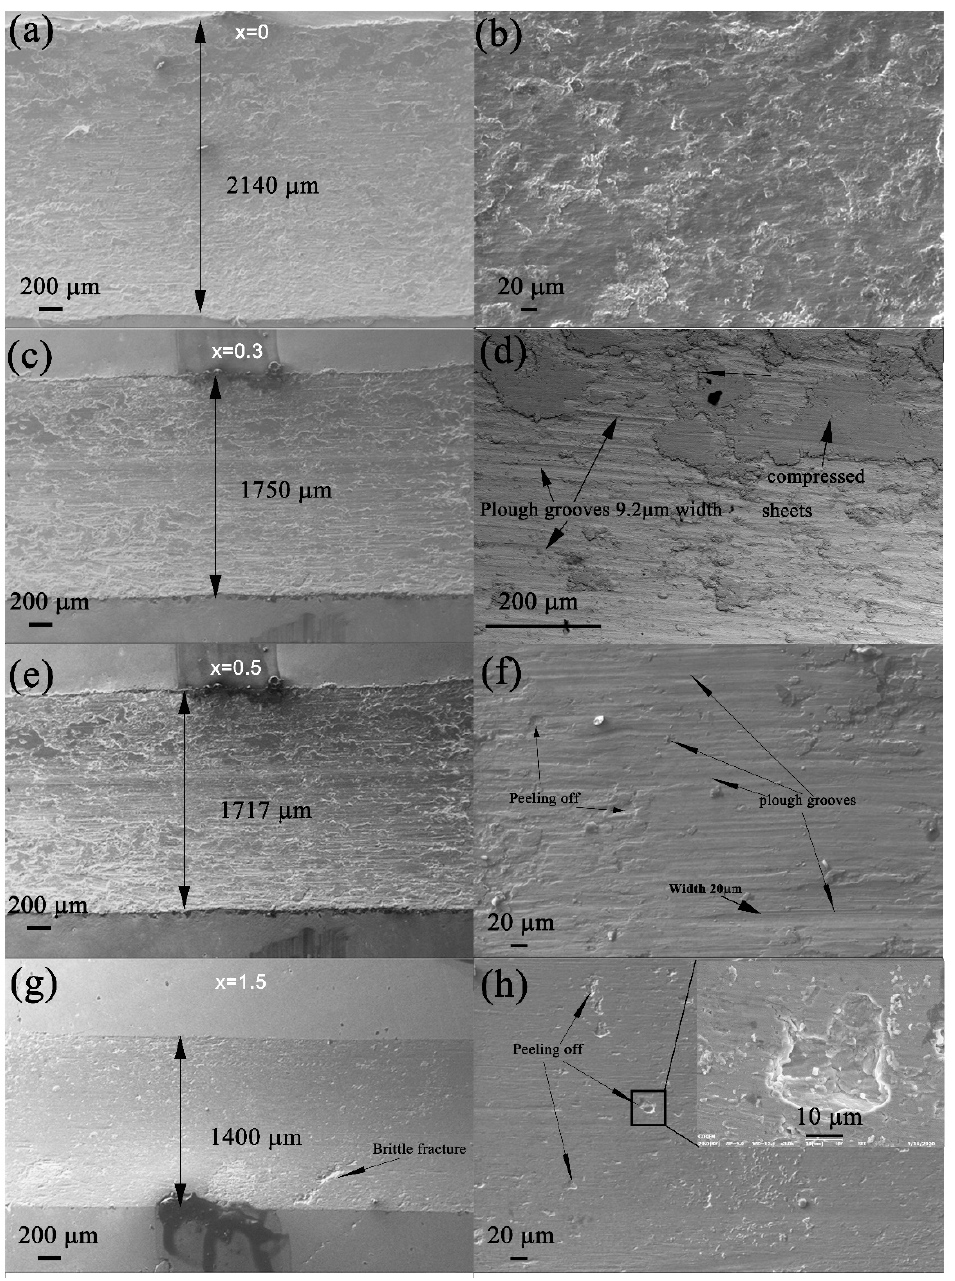
Figure 11. Volume loss, specific wear rates, and the average surface roughness (Sa) of wear scars for Mo x ( x = 0, 0.3, 0.5, 1, 1.5) high entropy alloys, ( a ) and ( b ) for Mo0 alloy, ( c ) and ( d ) for Mo0.3 alloy, ( e ) and ( f ) for Mo0.5 alloy, ( g ) and ( h ) for Mo1.5.